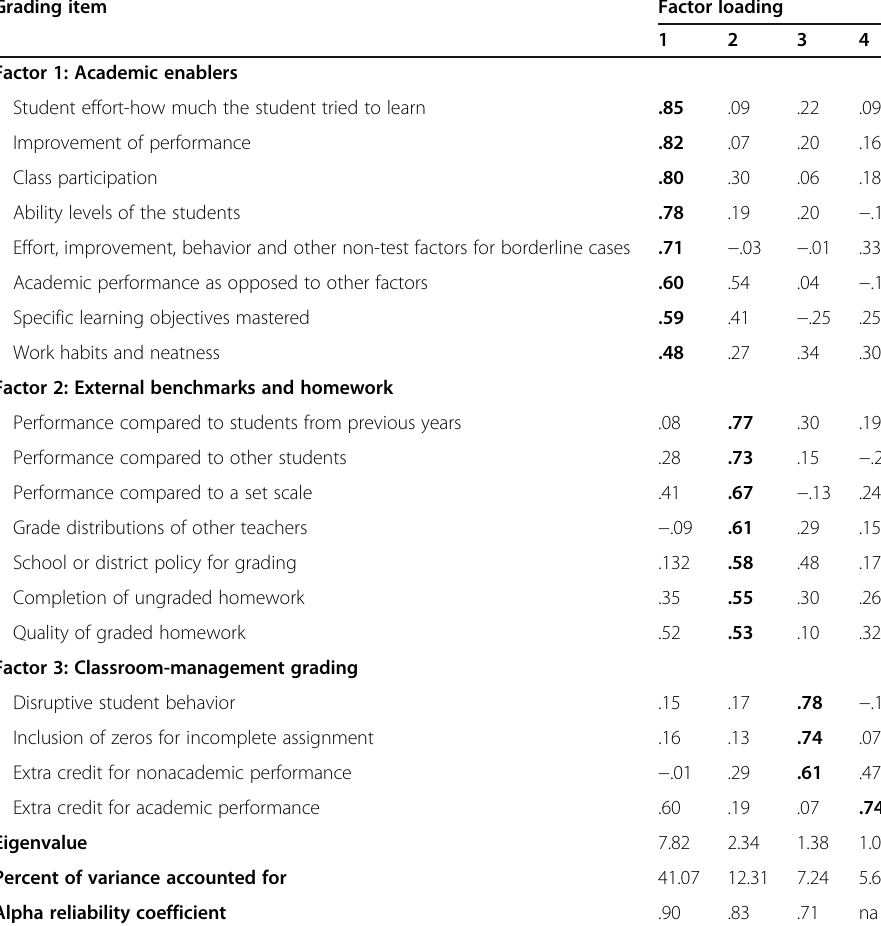
Table 2 PCA outputs for secondary EFL teachers ’ dataset Grading